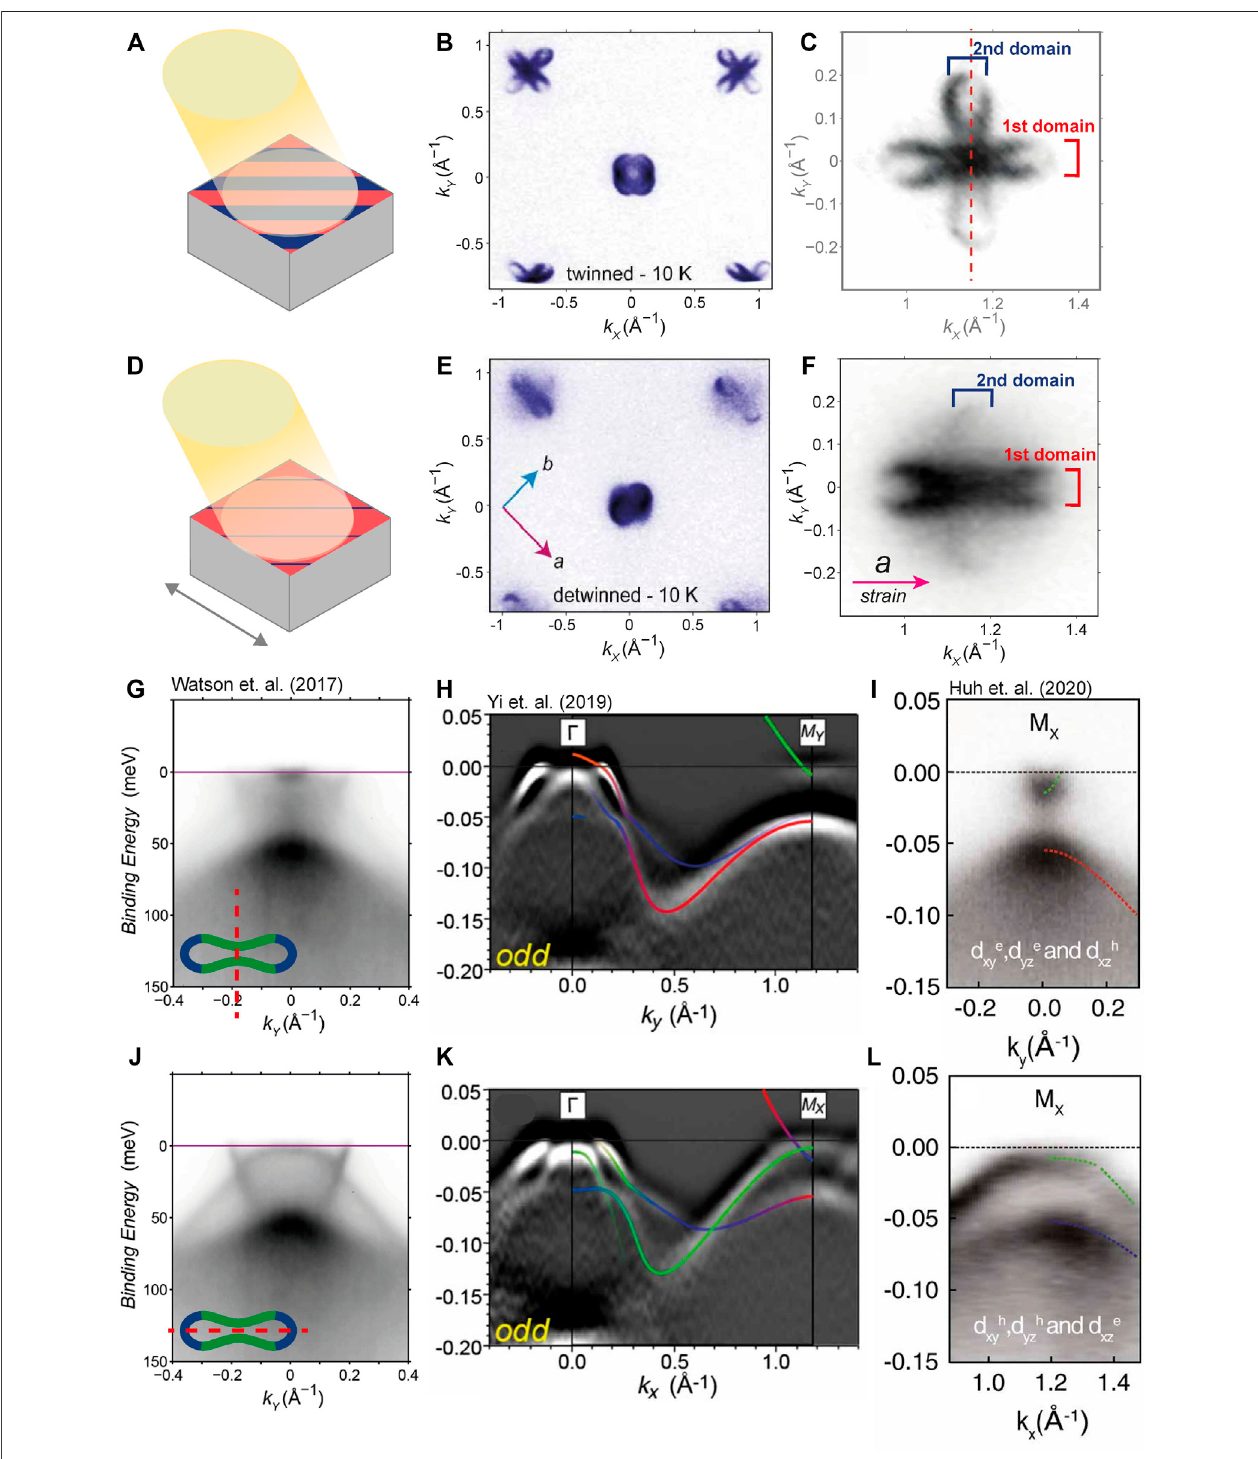
FIGURE3| SummaryofARPESmeasurementsonFeSeinthenematicstate. (A) Sketchofaphotoemissionsetuponatwinnedcrystal,showingequalcoverageof bothredandblueorthorhombicdomains. (B) Fermisurfacemeasuredfromameasurementonatwinnedcrystal( h ] =56 eV).TakenfromWatson et.al. [34] (C) Closeup of the electron pocket near the A point from Watson et. al. [32] ( h ] = 56 eV). (D – F) Equivalent sketch and measurement for a detwinned crystal of FeSe, which probes a majority of orthorhombic domains aligned in one direction. (G) Band dispersion of a detwinned crystal centered at the electron pocket. The insert shows the band